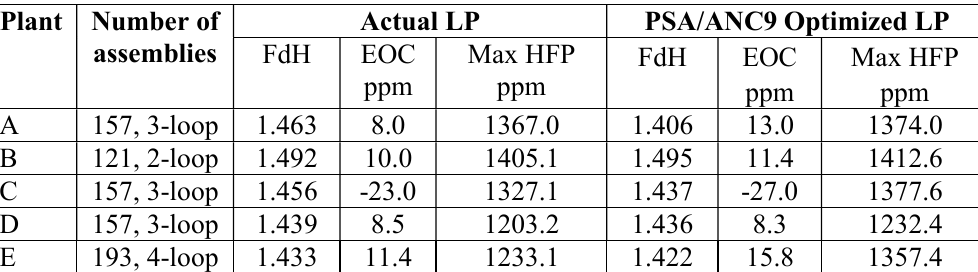
Table I. PSA/ANC9